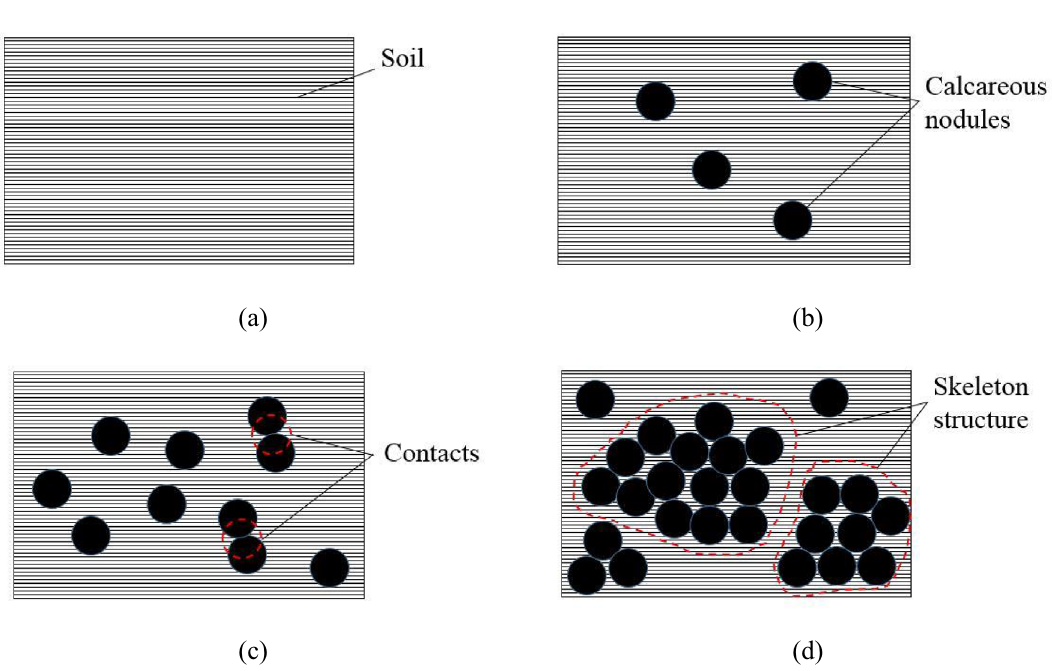
Figure 8. Schematic diagram of skeleton effect formation of calcareous nodules with CNC of ( a ) 0%, ( b ) 10%–20%, ( c ) 20%–30% and ( d )